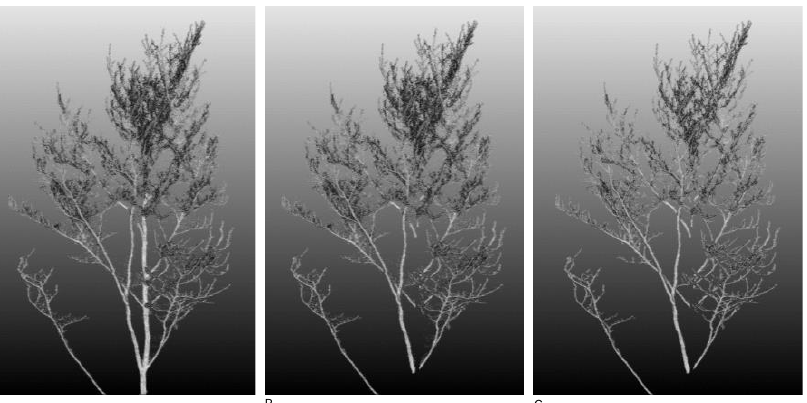
Figure 4. ( A ) Merged single tree point cloud. ( B ) Point cloud with stem axis removed. ( C ) after noise removal.